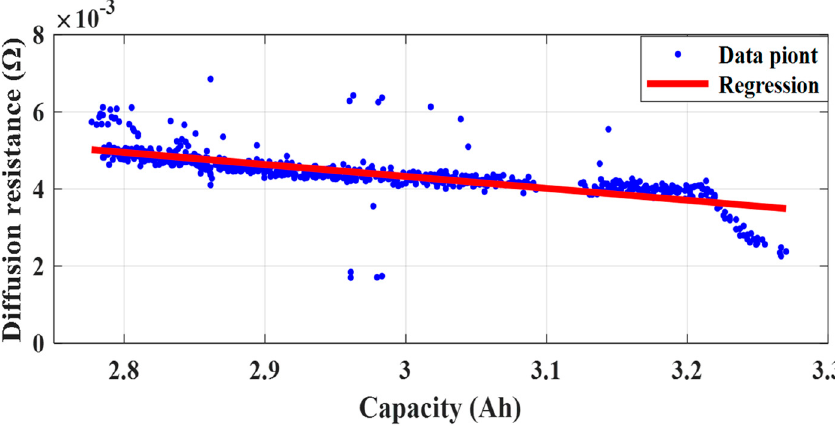
Figure 9. Linear fitting and residual analysis of the capacity and diffusion resistance.